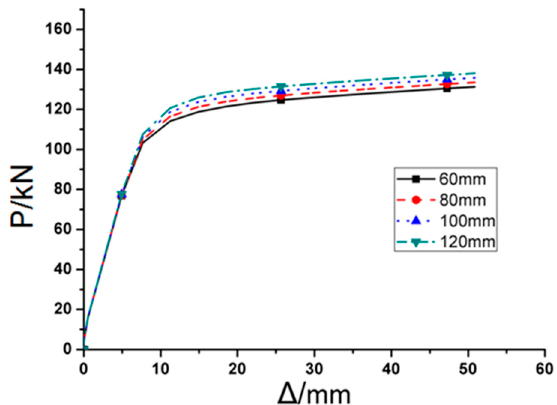
Figure 7. The load-displacement curves of RA series finite element (FE) joint models under monotonous load.